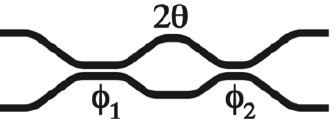
Figure 2. The schematic drawing for the MZDC